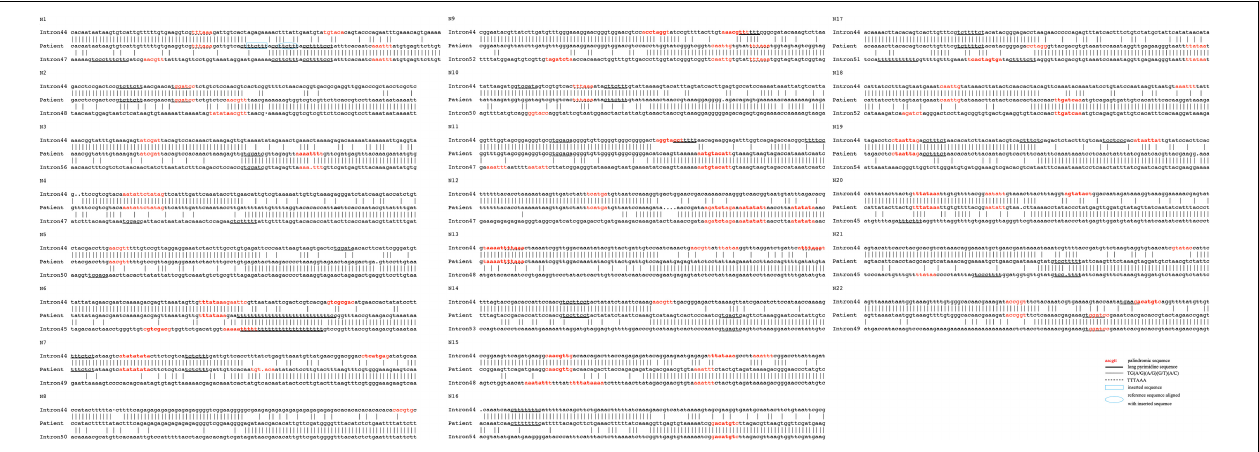
FIGURE 3 | Genomic sequences spanning 22 deletion breakpoints with corresponding reference intron sequences. Only the 5 (cid:48) –3 (cid:48) strands are shown. Palindromic sequences are presented in red color. Black underlines indicate long pyrimidine sequences, black dotted lines indicate TG(A/G)(A/G)(G/T)(A/C), and red dotted lines indicate TTTAAA. The inserted sequence is highlighted in a blue rectangle and the reference sequence that was aligned with the inserted sequence is highlighted in a blue circle.